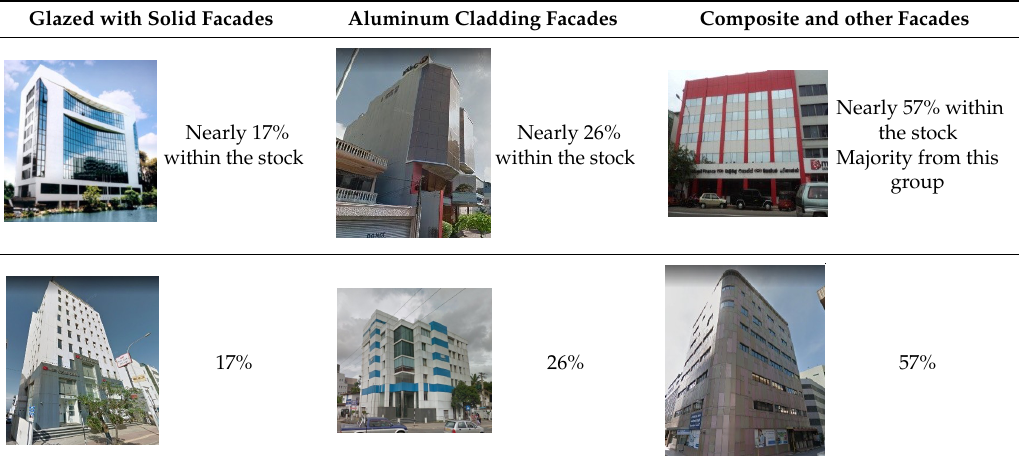
Table 3. Fenestration details of road facing façades and percentage distribution within the stock. Glazed with solid facades